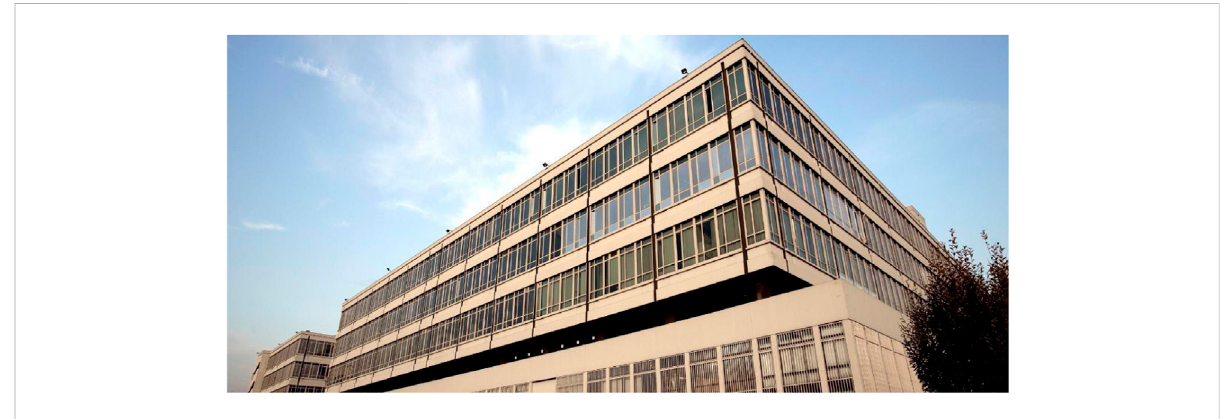
FIGURE 5 First demonstrator, Piero della